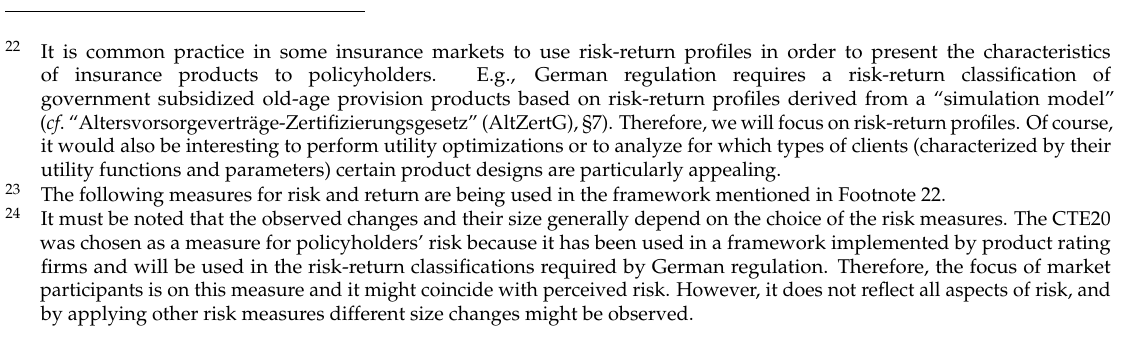
Reduced risk for alternatives 1/2 ( SCR mkt =